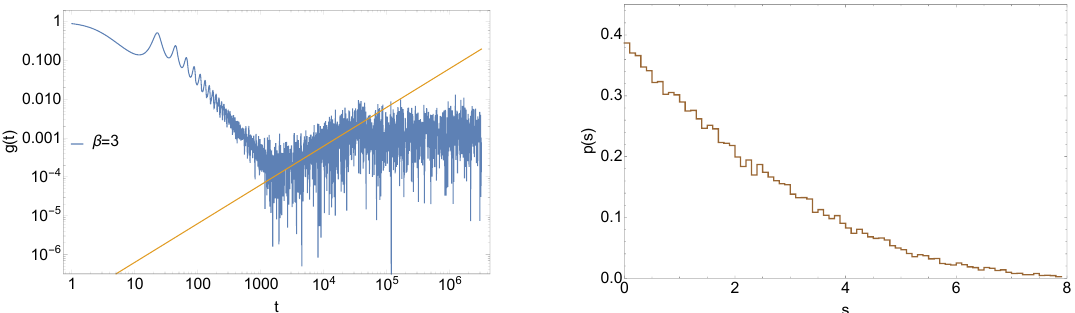
Figure 13. SFF (left) and its corresponding level spacing (right) for 3 d Rindler normal modes with ξ = 15 , n = 300 , J = 200 , β = 3 and R = 2 , a = 1 . Equation of the yellow straight line 0 cut cut on the left is log g ( t ) = log t +